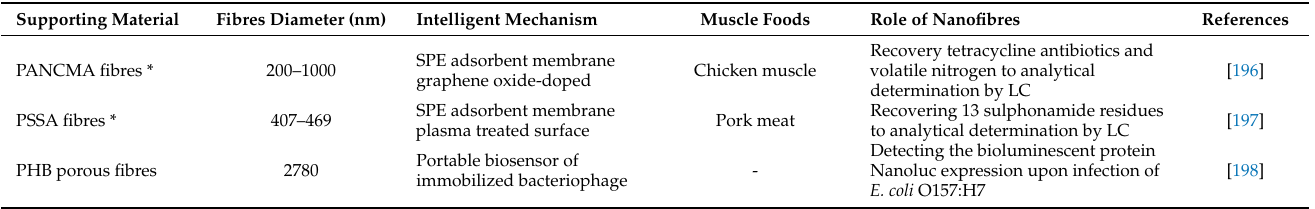
Table 3. The application and mechanisms of electrospun fibres in meat processing and